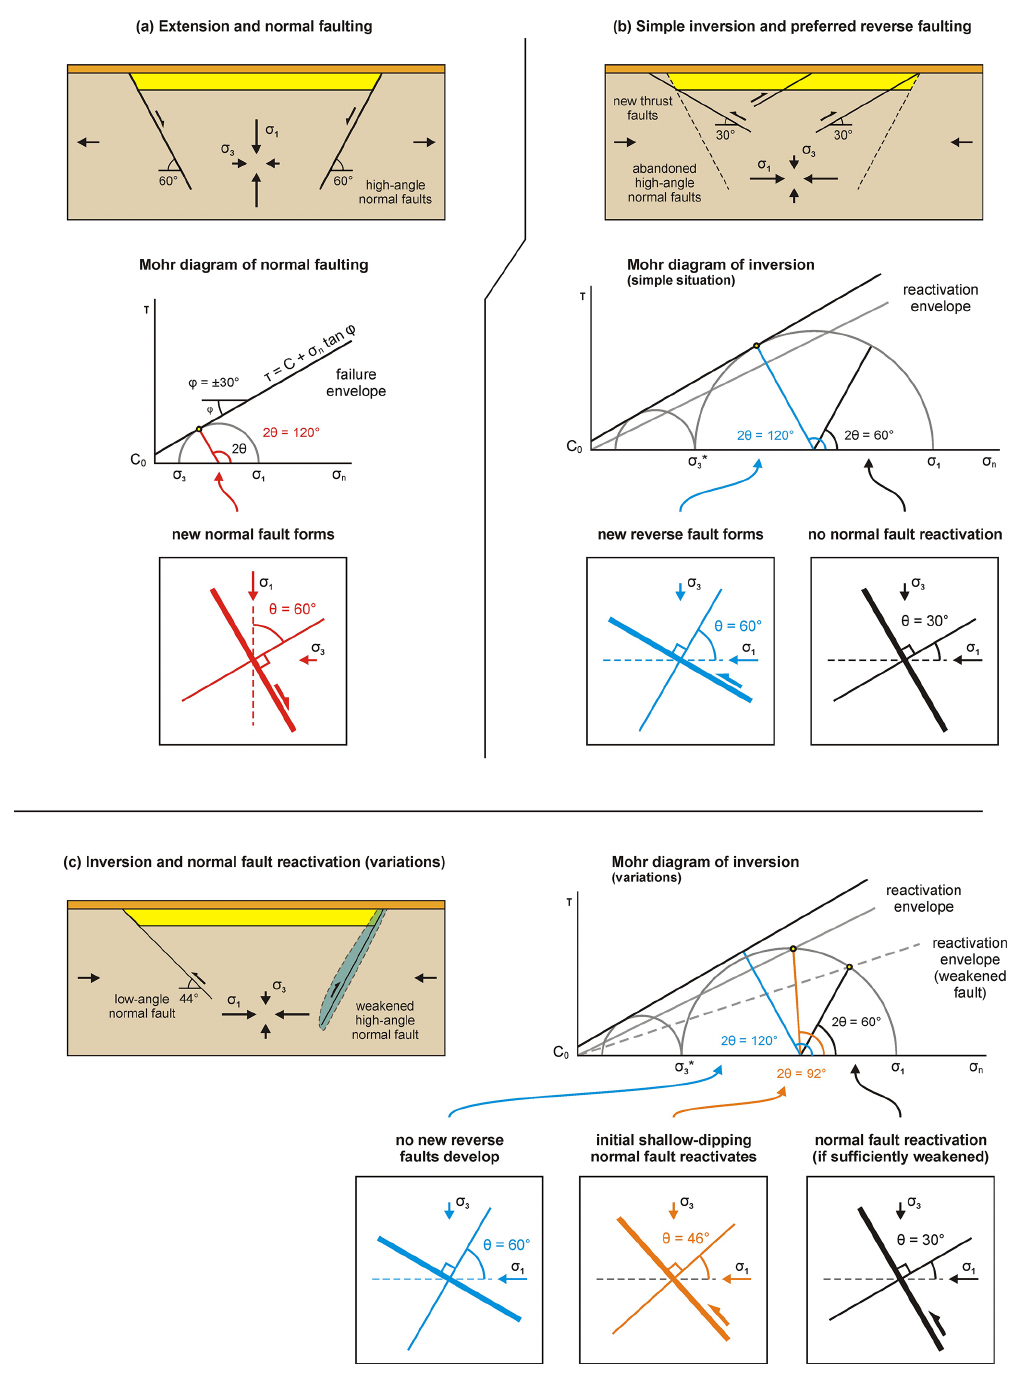
Figure 2. Schematic 2D illustration of (a) basin development, (b) inversion with preferential new reverse fault development over reactivation of steep normal faults, and (c) inversion style variations involving normal fault reactivation due to reduced normal fault dip and fault strength, including schematic Mohr diagrams of the changing states of stress in these systems ( σ 1 = maximum compressive stress; σ 3 = minimum compressive stress; θ = angle between normal to fault plane and orientation of the maximum compressive stress ( σ 1 ); ϕ = angle of internal friction; C 0 = cohesion; τ = shear stress; σ n = normal stress). The reactivation envelope concerns the reactivation of a pre-existing fault plane, which is considered to involve negligible cohesion ( C 0 = 0Pa) so that the envelope starts from the origin. ( ∗ ) Note that σ 1 (vertical loading) during extension becomes σ 3 during subsequent inversion in 2D (as indicated by the small semi-circles in the Mohr diagrams in panels b and c ). Inspired by Bonini et al.